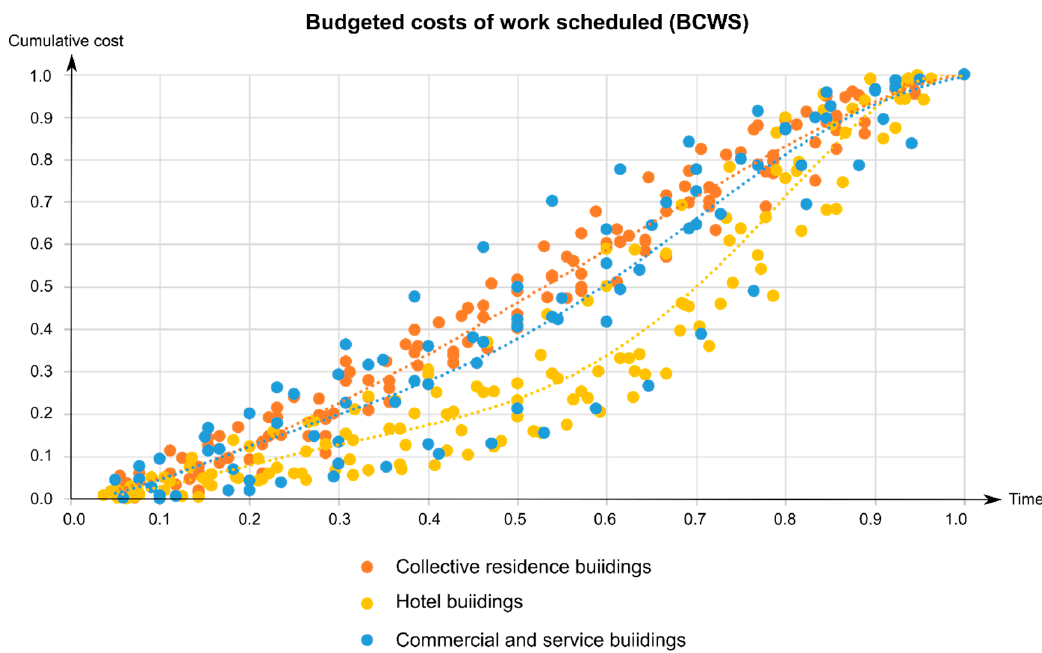
Figure 6. Best fit 3-degree curves and curve spaces for budgeted costs of work scheduled.